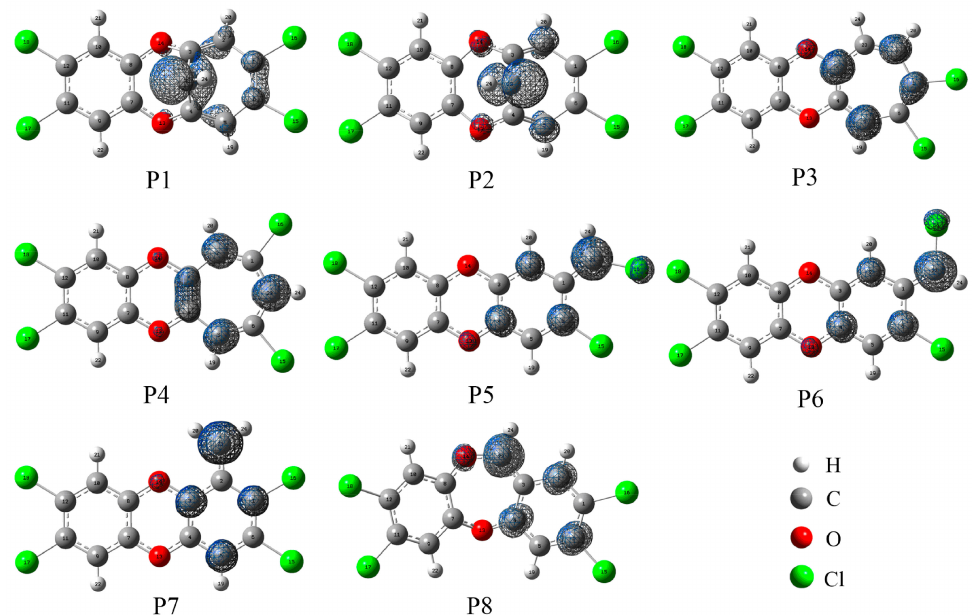
Figure 6. Spin density maps for the products. The isodensity contours are 0.005 electron/bohr 3 .